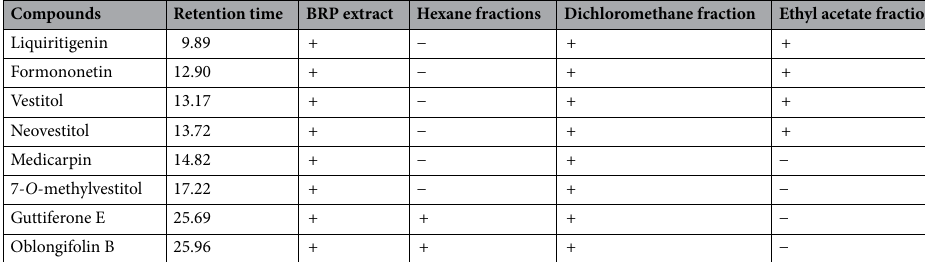
Table 1. Major phytochemical compounds identified in the BRP extract and its fractions by HPLC.